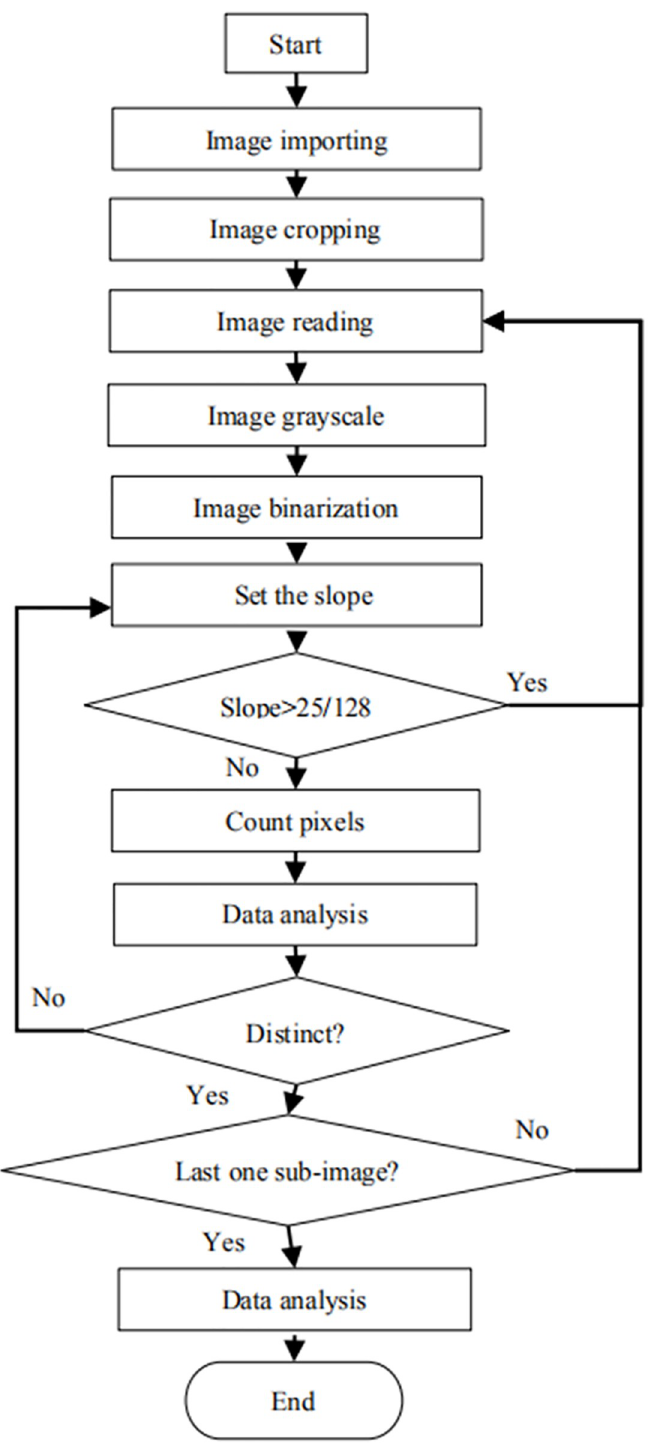
Fig 3. Flow chart of the